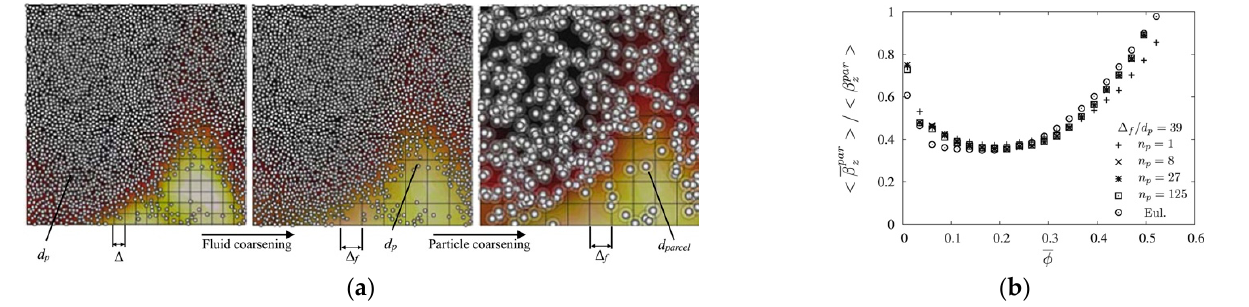
Figure 8. Effect of the fluid and particle coarsening on the drag coefficient at different coarse graining degree. ( a ) Graphical example of the fluid-particle coarsening sequence leading to large cell sizes compared to the actual particles; ( b ) effect of the solid volume fraction ( φ = 1 − ε ) and number of particles per grain ( n p = n CG in the present notation) on the normalized filtered drag coefficient 𝛽 . Reprinted from [81], with permission from Elsevier.